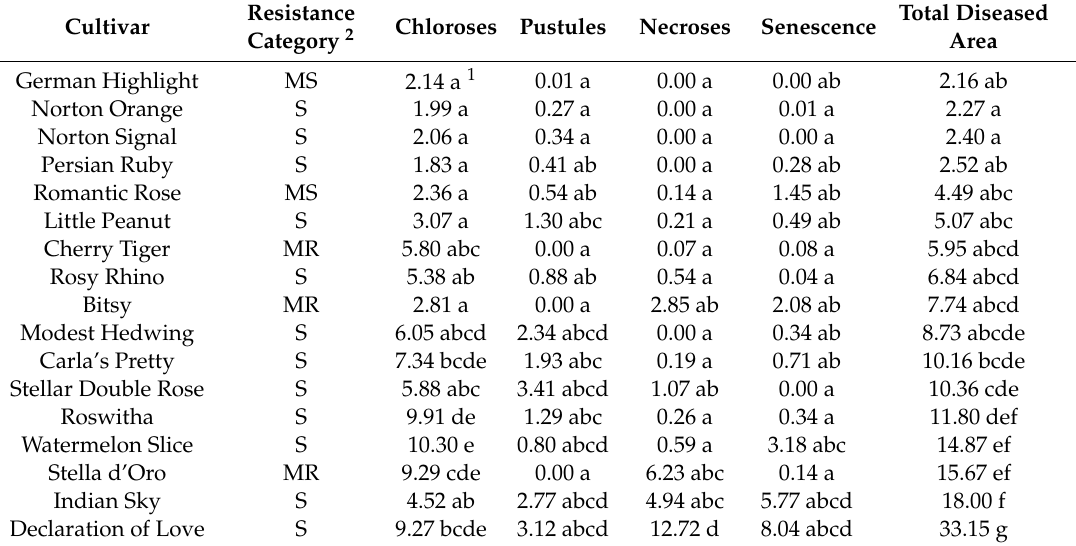
Table 6. Average percentage of leaf area corresponding to chloroses, pustules, necrosis, senescence and total diseased area for each cultivar of Hemerocallis inoculated with Puccinia hemerocallidis and respective statistical analysis using the Tukey test ( p < 0.05).